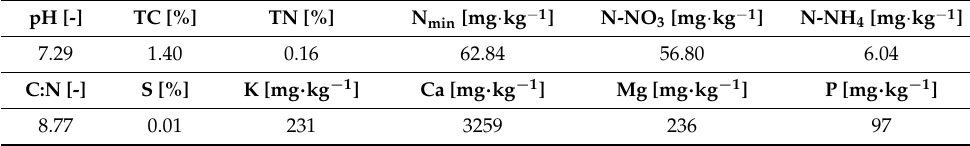
Table 3. Properties of soil used for the pot substrate